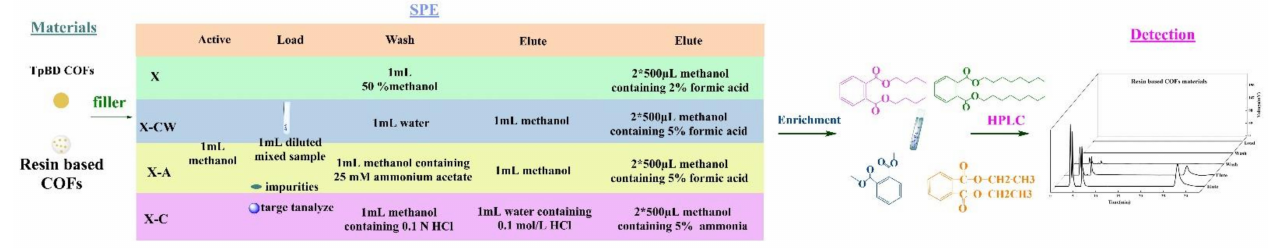
Figure 1. SPE flow